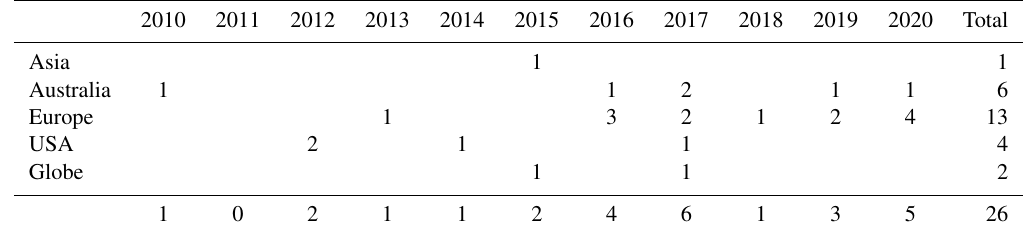
Table 3. Papers selected as the primary focus of this review by publication year and study area